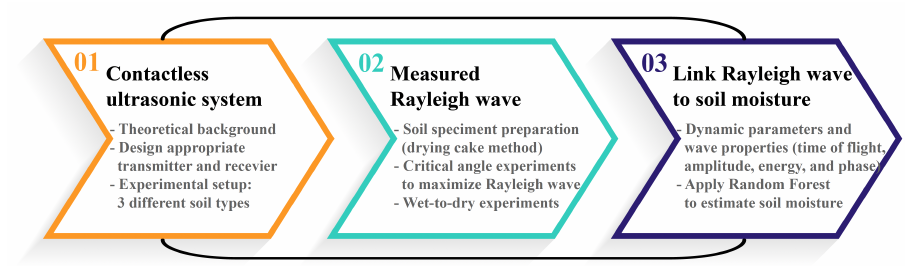
Figure 1. Overview of the proposed contactless ultrasonic method used in this study to estimate soil